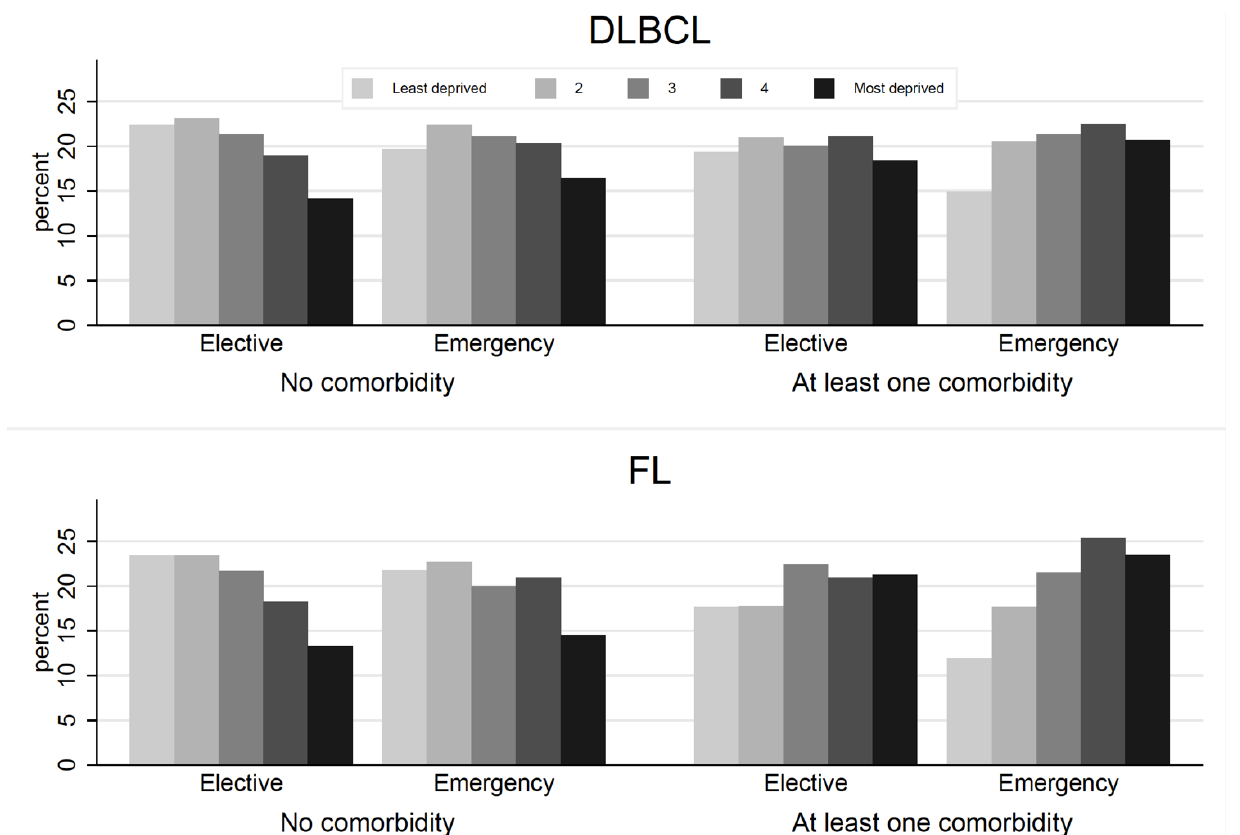
Figure 2. Distribution of deprivation levels by diagnostic route stratified over comorbidity status amongst patients diagnosed with DLBCL ( n = 27,379) or FL ( n = 14,043) in England between 2005 and 2013.